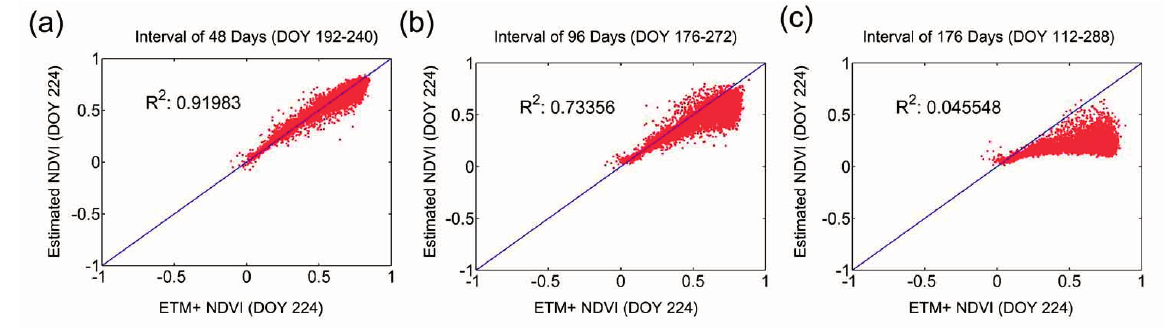
Figure 11. Input data time interval and the NDVI blending accuracy. Blending accuracy with a time interval of: ( a ) 48 days; ( b ) 96 days; and ( c ) 176